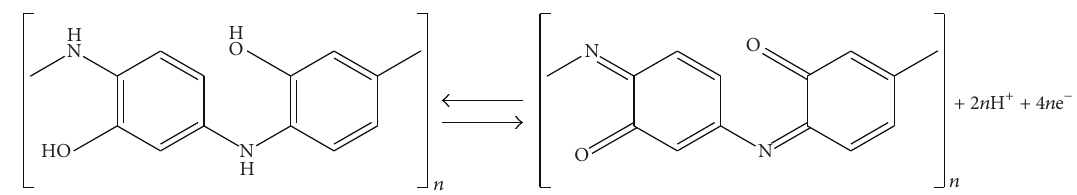
F 14: Stoichiometry of redox reactions of POAP �lm electrode [7].